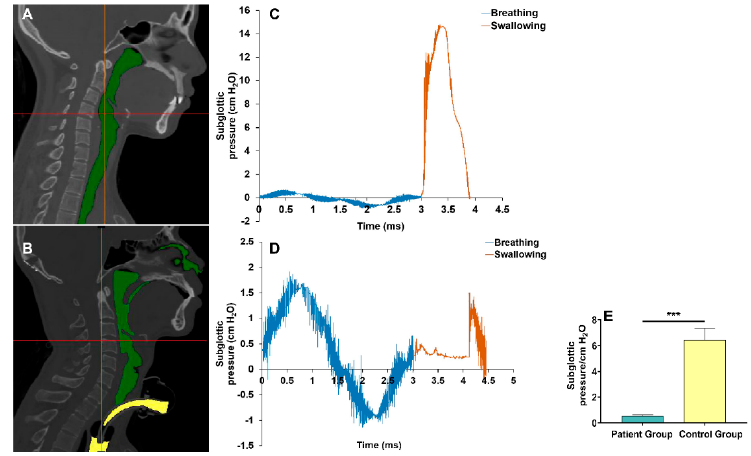
Figure 3. Comparison of the subglottic pressure during swallowing between the patient group and control group: ( A ) Three–dimensional reconstruction of the upper airway anatomical structure in a healthy subject (green area, upper respiratory tract). ( B ) Three–dimensional reconstruction of the upper airway anatomical structure in a tracheostomized patient with aspiration following ABI (green area, upper respiratory tract; yellow area, tracheal tube). ( C ) The trend of subglottic pressure in a healthy subject during swallowing. ( D ) The trend of subglottic pressure in a tracheostomized patient with aspiration following ABI during swallowing. ( E ) Comparison of the subglottic pressure during swallowing showed there was a significant difference between the patient group and control group. Note: *** p < 0.001.